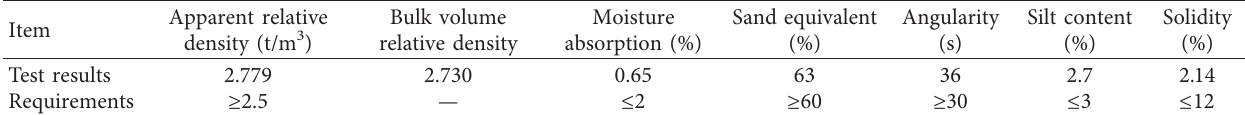
Table 5: Test Results of fine aggregates.